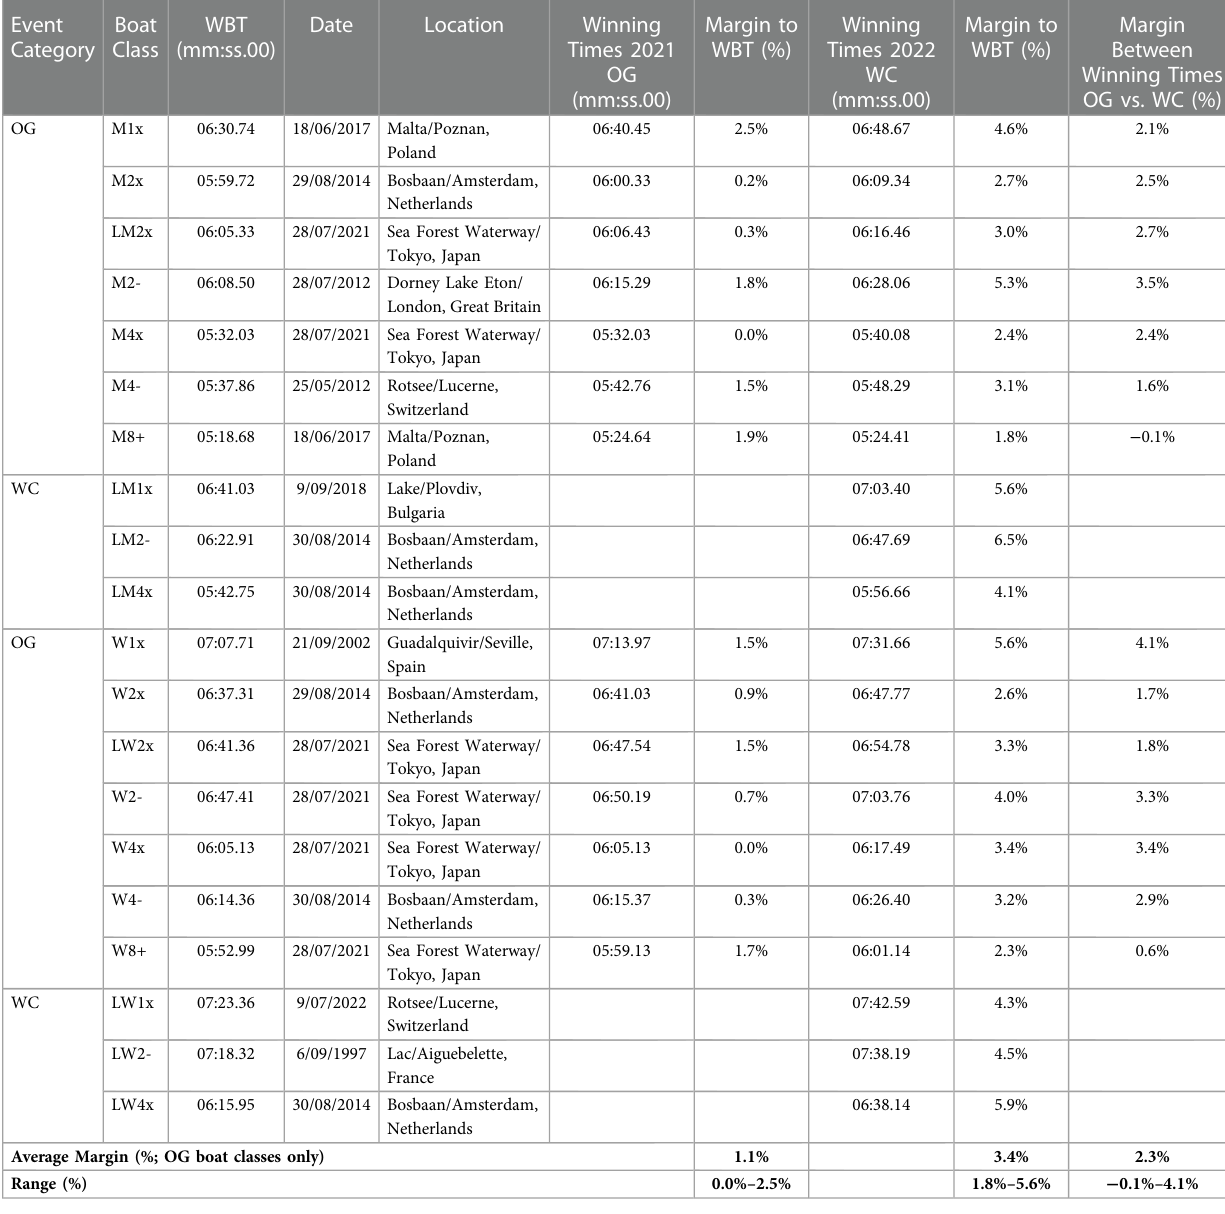
TABLE 1 World ’ s best times (WBT; current to end of December 2022) across Olympic games (OG) and world championships (WC) boat classes for both men and women, including date and location they were set. Presented in comparison to winning events times at 2021 Olympic games (Sea Forest Waterway/Tokyo, Japan) and 2022 World Championships (Racice, Czech Republic) across each of these boat classes (source, https://worldrowing. com/). Event Boat Category